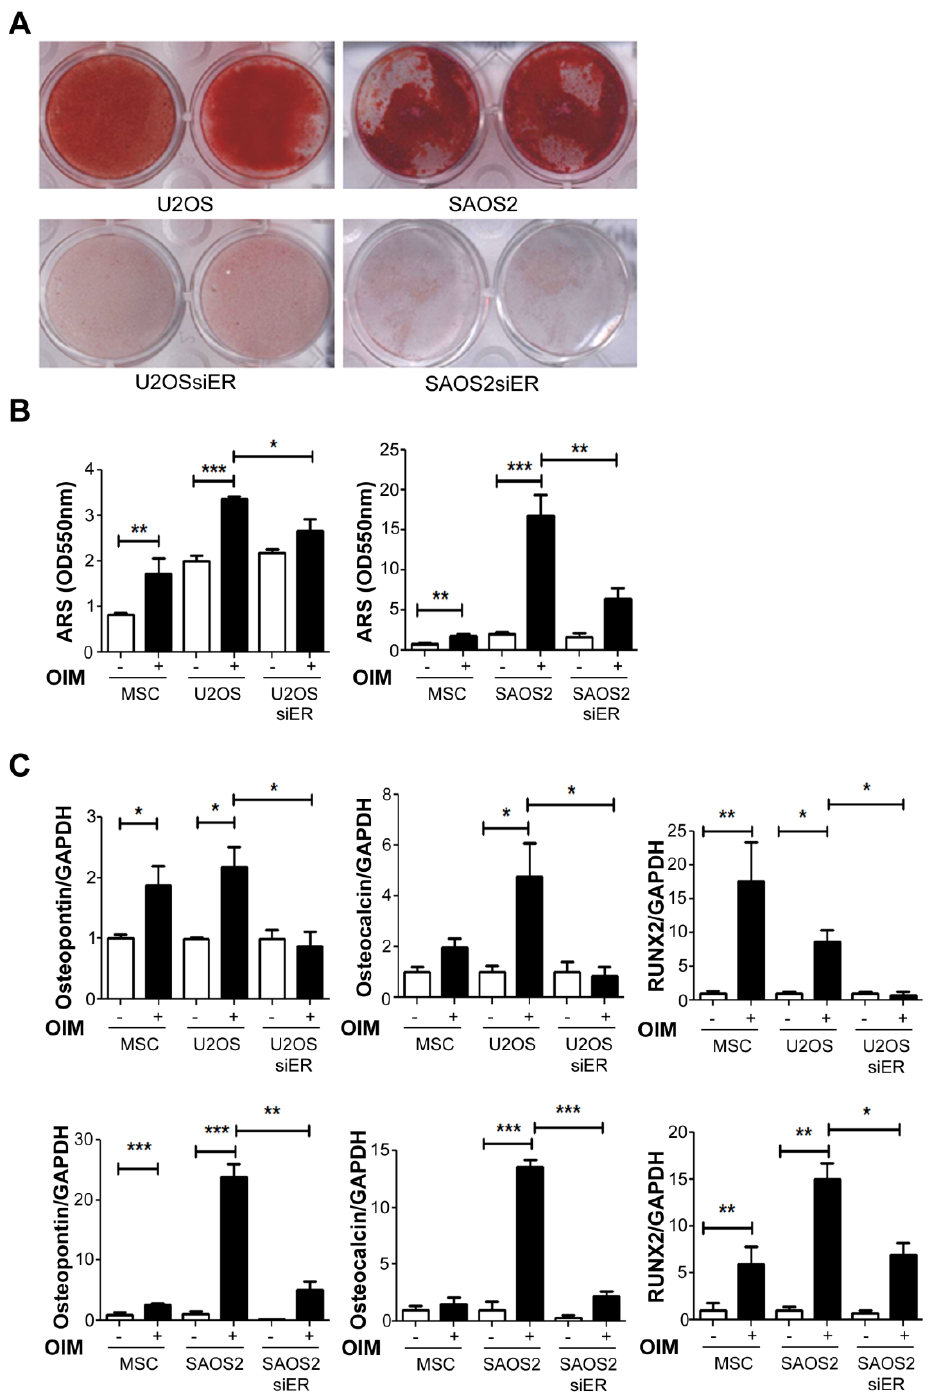
Figure 3. Knockdown of ER α suppressed the osteogenesis abilities of both the P53+ U2OS and P53 − SAOS2 cells. ( A ) The cells were cultured in OIM for up to 2 weeks to induce osteogenesis and were analyzed by ARS staining. ( B ) ARS staining was conducted, and the OD values were measured for quantification. ( C ) The gene expression levels of osteopontin, osteocalcin, and RUNX2 were analyzed by quantitative RT-PCR assay7 days after induction. Anormal mesenchymal stem cell (MSC) line was used as a positive control. Compared to the parental cells, the SiER α cells had significantly decreased levels of osteogenic genes. * p < 0.05, ** p < 0.01, and *** p < 0.005 compared to parental cells.